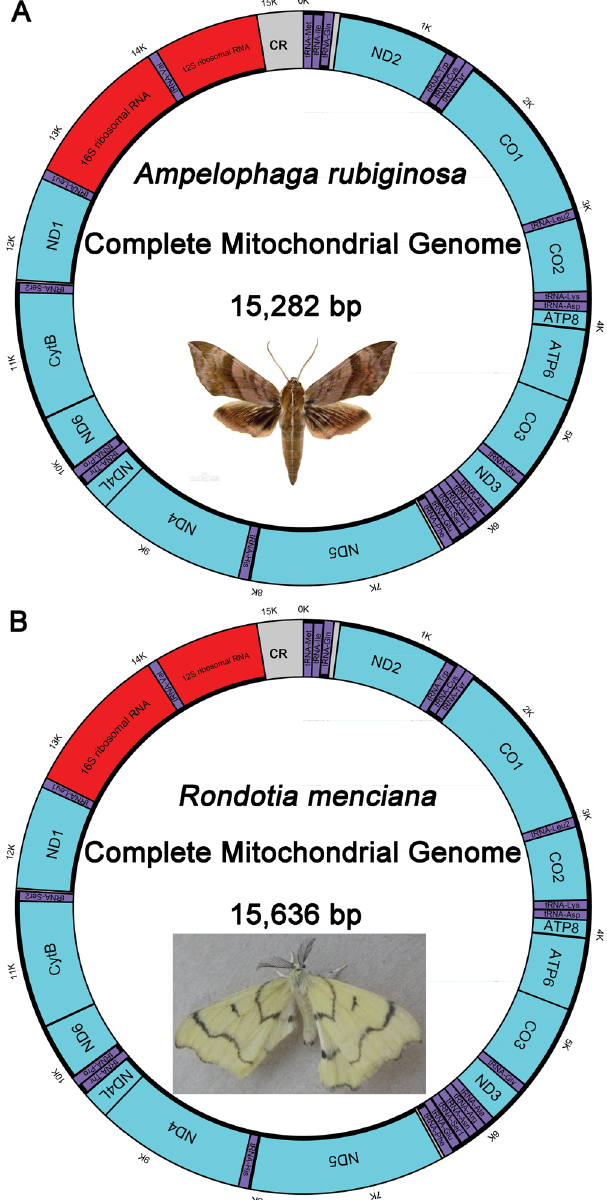
Figure 1. Circular map of the mt genomes of A . rubiginosa ( A ) and R . Menciana ( B ). tRNA - Ser1 , tRNA - Ser2 , tRNA - Leu1 and tRNA - Leu2 denote codons tRNA - Ser1 (AGN), tRNA - Ser2 (UCN), tRNA - Leu1 (CUN), and tRNA - Leu2 (UUR),